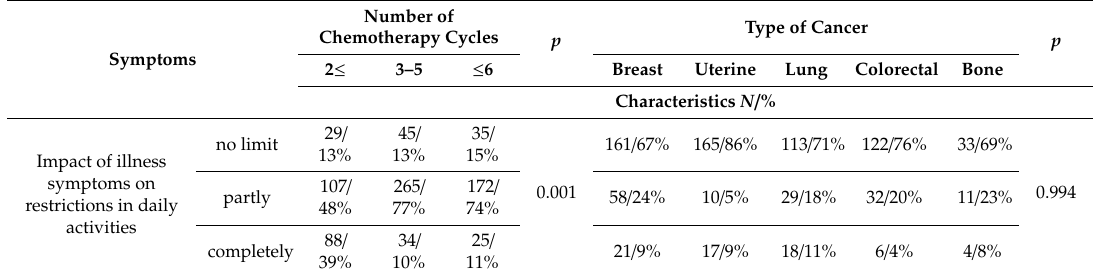
Table 4. Impact of physical ailments related to the disease on limitations in everyday basic